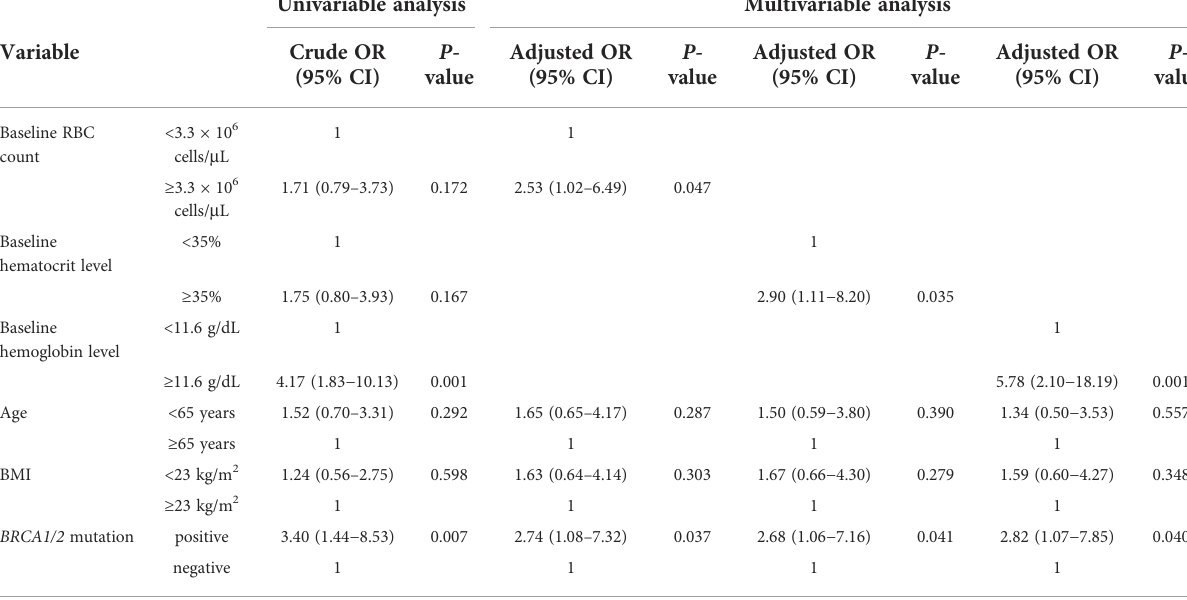
TABLE 3 Patient-speci fi c risk factors associated with the onset of grade ≥ 1